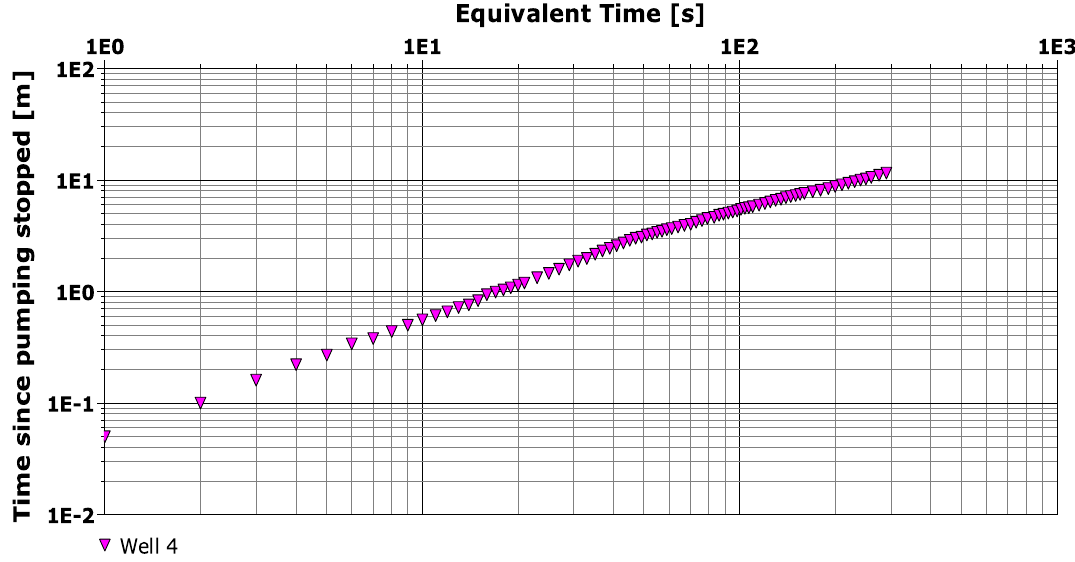
Fig. 9 Plotting of recovery rate of well-4 using aquifer mapping software